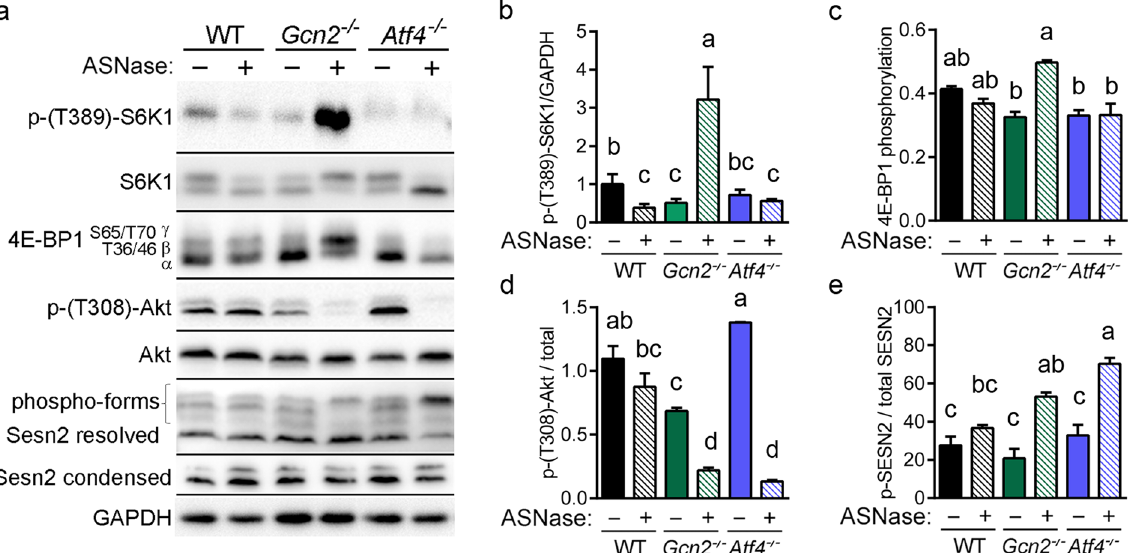
Figure 5. The mTORC1 pathway is amplified in livers from Gcn2 − / − but not Atf4 − / − mice following 8 daily injections of asparaginase (3 IU per gram body weight, ASNase). ( a ) Representative immunoblots for panels (b– e). ( b ) The ratio of phospho-S6K1 at threonine 389 to glyceraldehyde 3-phosphate dehydrogenase (GAPDH). ( c ) Phosphorylation of 4E-BP1 expressed as the ratio of the γ -form to the α + β + γ sum. ( d ) The ratio of phospho Akt at threonine 308 to total Akt. ( e ) The ratio of Sestrin2 phospho-forms to the sum of all Sesn2 resolved forms. Data are represented as the average value ± standard error of the mean, n = 4–6 per group. Means without a common letter are different according to Tukey post hoc analysis following ANOVA, P < 0.05. Full immunoblots are presented in Supplementary Fig.